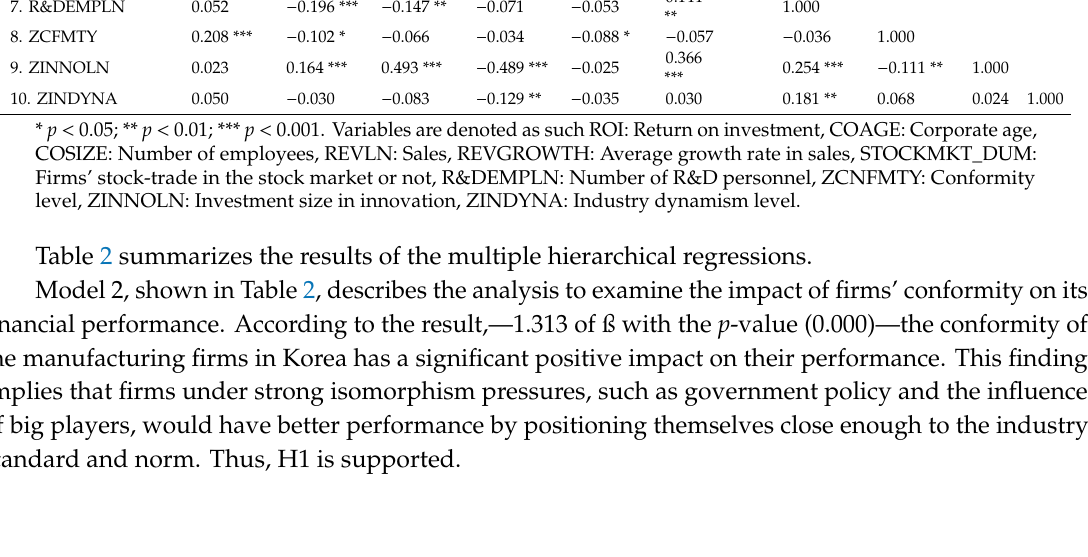
Table 2. Multiple Hierarchical Regression for Return on Investment.